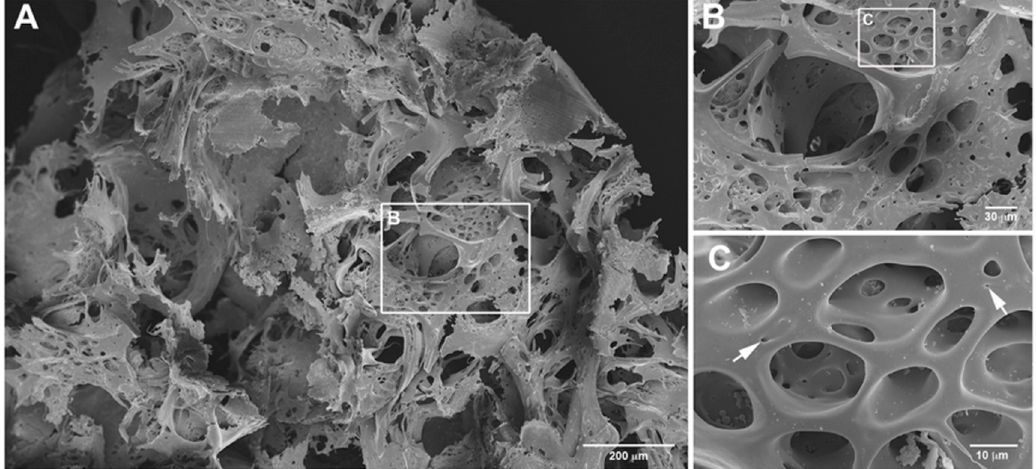
Figure 4. Silk–fibroin scaffold (SSF) morphology analyzed by FE–SEM. ( A ) SSF after the fabrication process displaying the sponge morphology of the sample characterized by high level of porosity and both the smoothness and coherence of the trabecular surfaces. ( B , C ) high magnification of the same marked area found, respectively, in A and B .